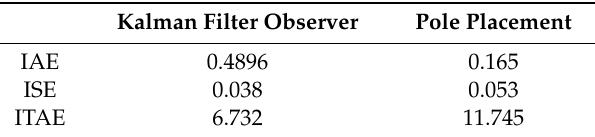
Table 2. Performance